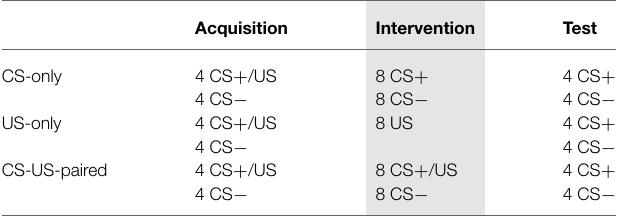
TABLE 1 | Overview of the experimental phases and groups. Acquisition